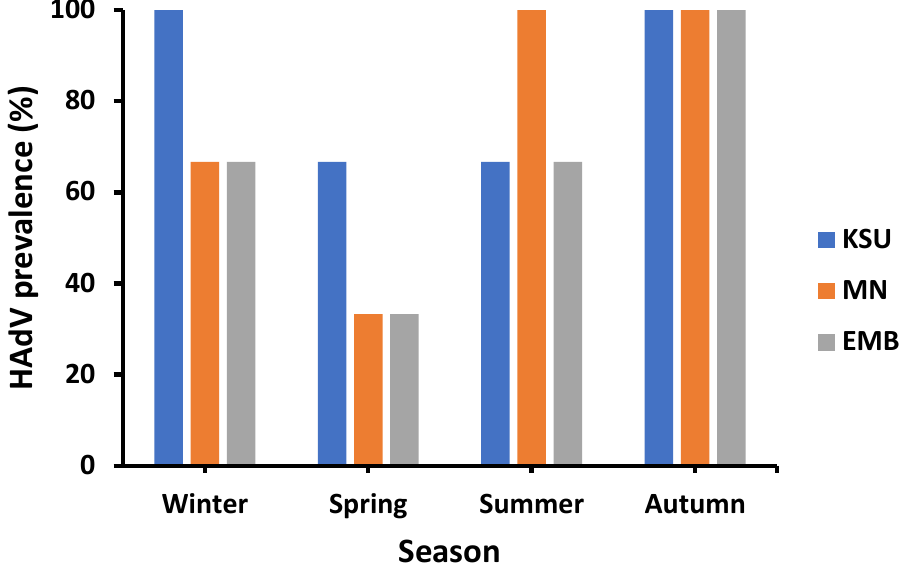
Figure 4. Seasonal prevalence of HAdVs among sampling areas.